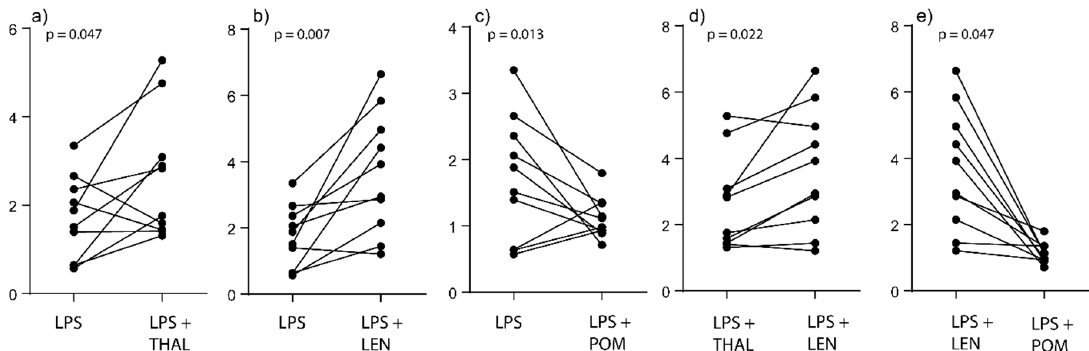
Figure 3. The effect of IMIDs on the metabolism of normal monocytes; analysis of the spare respiratory capacity. Normal monocytes derived from 10 healthy individuals were cultured with LPS 1 ng/mL alone or in combination with an IMiD (5 μ g/mL). Monocyte metabolism was analyzed using the XF Mito Stress Test assay and the Seahorse XF 96 cell analyzer. The figure presents the results for all statistically significant comparisons. The cultures compared in each of the statistical analyses/diagrams are indicated on the x -axis, the spare respiratory capacity is indicated on the y -axis (pmol/min/50 μ g protein) and the p -value for the statistical analysis (Wilcoxon test for paired samples) is indicated at the top of each diagram. We present the results for LPS stimulated cultures with and without an IMiD ( a–d ) and with two different IMiDs ( e ).